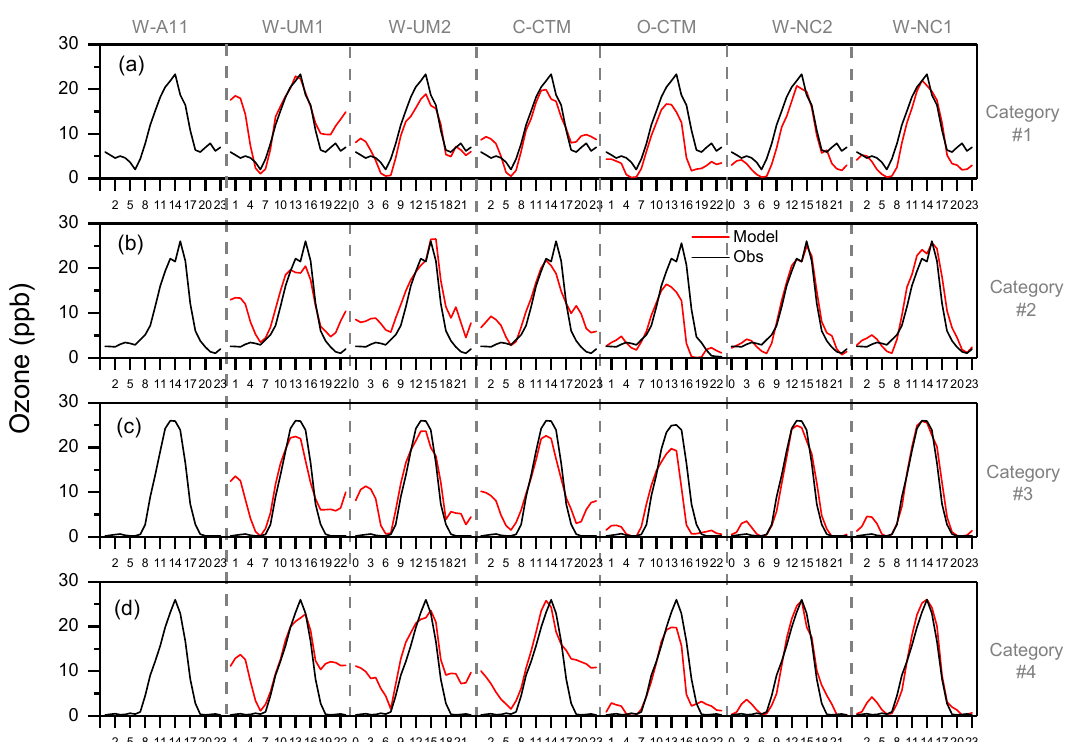
Figure 17. Diurnal composite observed (5 m) and modelled (z 1 average) O 3 at Westmead. Panels a—d represent each of the four radon-based mixing categories (Table 1).